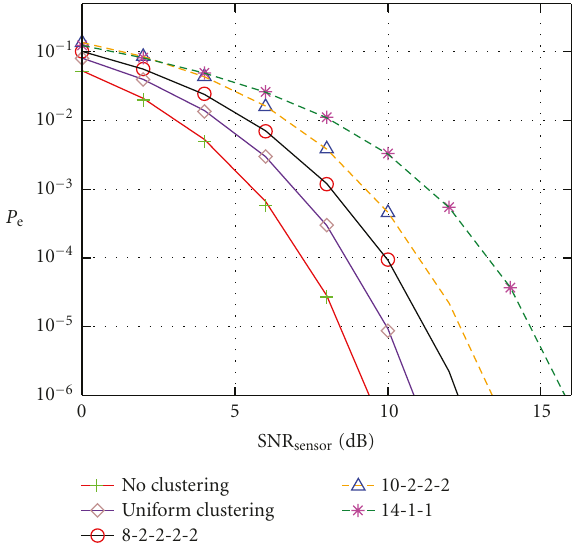
Figure 2: Probability of decision error, as a function of the sensor SNR, in a scenario with N = 16 sensors and equal a priori probabili- ties of the phenomenon ( p 0 = p 1 = 1 / 2). Three di ff erent topologies are considered: (i) absence of clustering, (ii) uniform clustering, and (iii) nonuniform clustering (in this case, the specific configurations are indicated explicitly). Lines are associated with analytical results, whereas symbols are associated with simulation results.